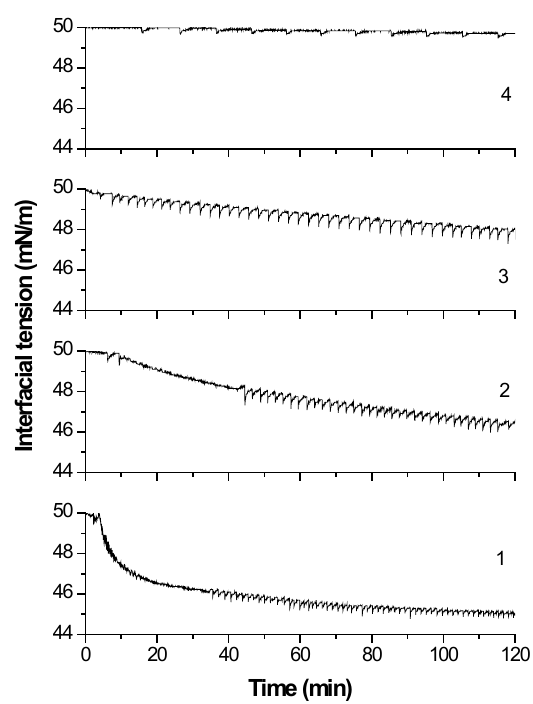
Figure 2: Dynamic regimes at heptane/water interface accompanying dissolution of a surfactant droplet in the water bulk : 1 – pentanol, 2 – hexanol, 3 – heptanol, 4 – octanol. Vessel diameter d=40 mm, capillary immersion depth h = 10 mm. Reprinted with permission from [8]. Copyright 2006